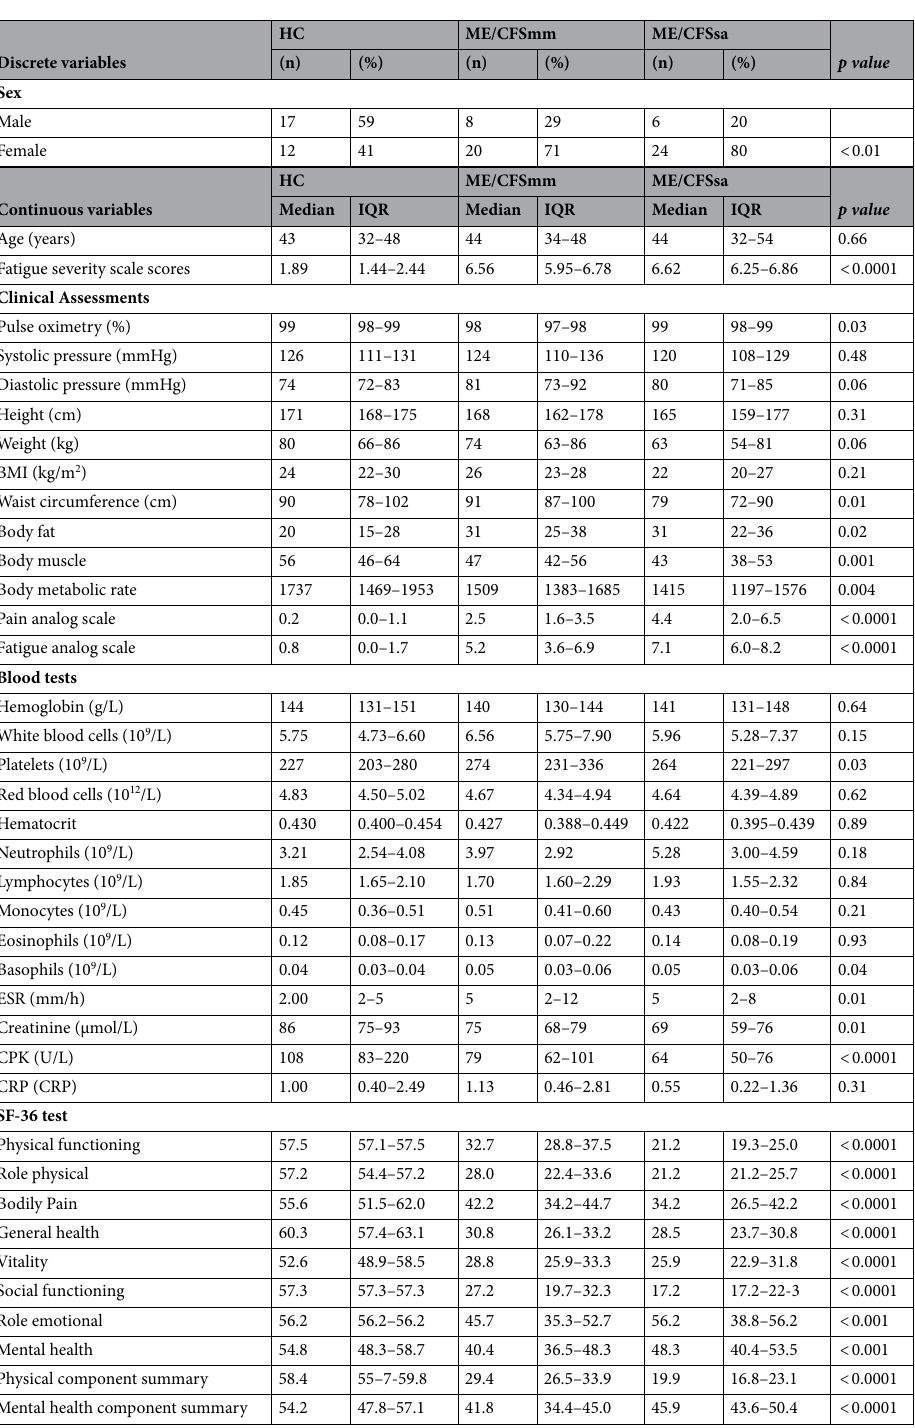
Table 1. Demographics of the study population based on sex, age, fatigue severity scale scores, clinical assessments, blood tests and SF-36 test. HC, participants recruited as healthy controls; ME/CFSmm, participants recruited as mild/moderate ME/CFS patients; ME/CFSsa, participants recruited as severely affected ME/CFS patients. Body mass index (BMI); erythrocyte sedimentation rate (ESR); creatine phosphokinase (CPK); C-reactive protein (CRP). * p values were obtained as follows: χ 2 tests for categorical variables, Kruskal–Wallis test for non-normally distributed continuous variables and ANOVA test for normally distributed continuous variables. Normal distribution was checked by D’Agostino & Pearson test. Note that the median and interquantile for CRP were obtained from fitting a linear regression based on a truncated Lognormal distribution to the respective